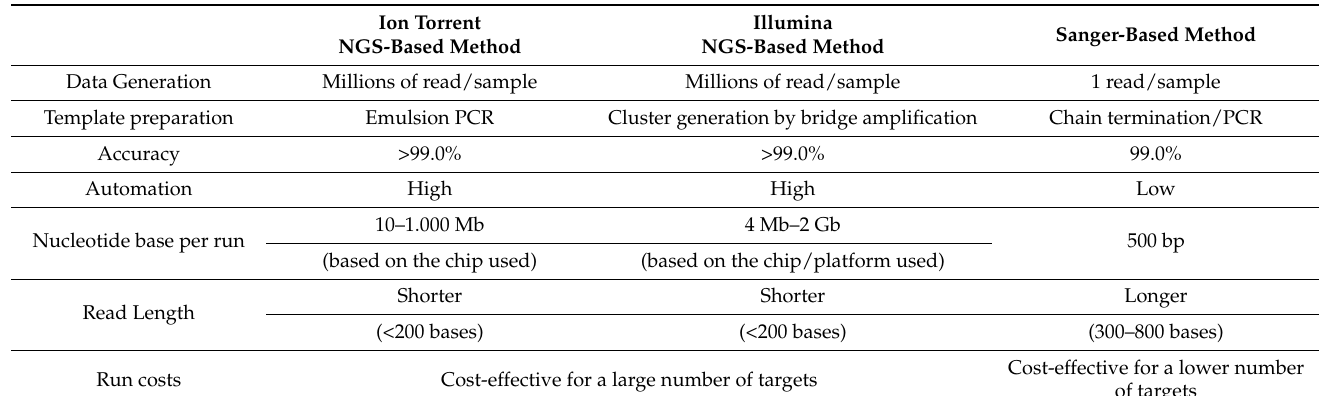
Table 4. Comparison between next-generation sequencing and Sanger